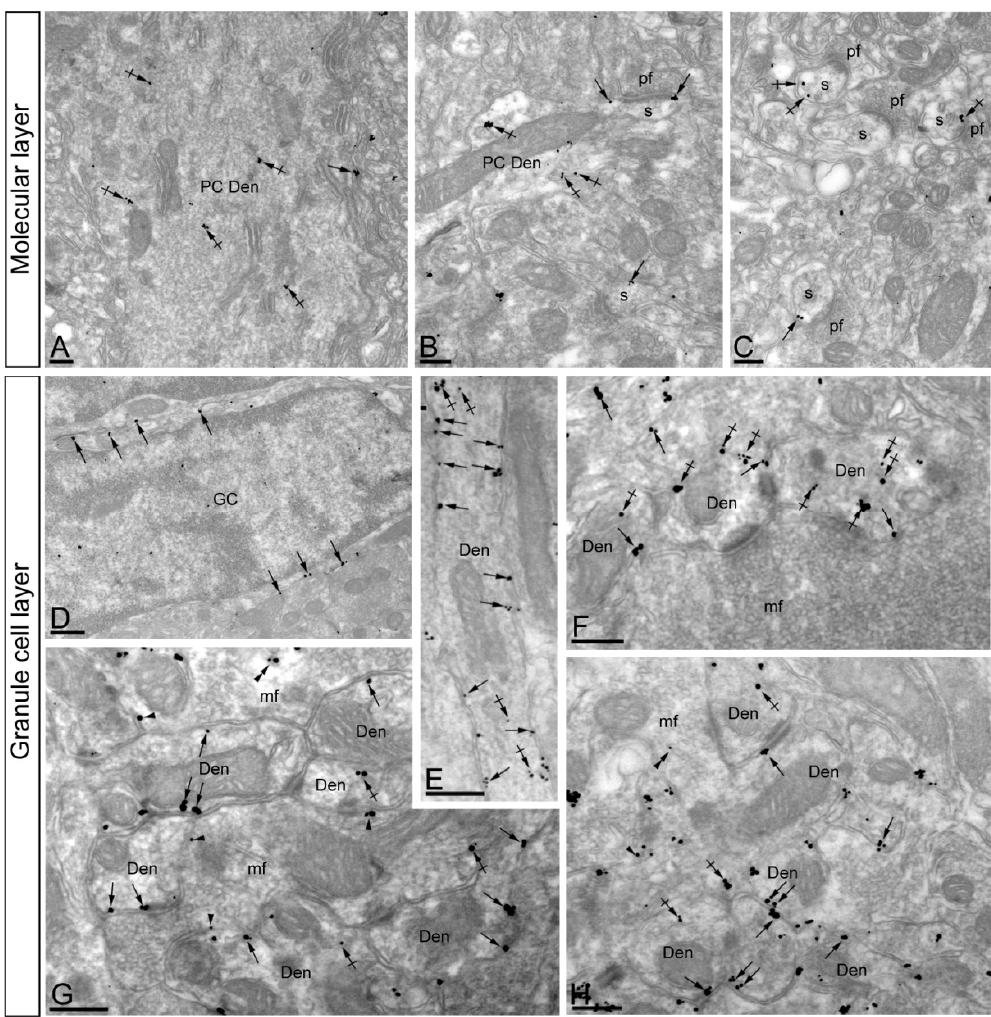
Figure 5. Subcellular localisation of Kv channel interacting protein (KChIP) subunit KChIP4 in the cerebellum. Electron micrographs showing immunoparticles for KChIP4 in the cerebellar cortex, as detected using the pre-embedding immunogold technique. ( A – C ) In the molecular layer, KChIP4 immunoparticles were detected in Purkinje cells, distributed along the extrasynaptic plasma membrane (arrows) of dendritic shafts (Den) and dendritic spines (s), as well as at intracellular sites (crossed arrows). ( D – H ) In the granule cell layer, immunoparticles for KChIP4 were mostly distributed along the somatic plasma membrane (arrows) and dendrites (Den) of granule cells (GC), as well as at intracellular sites (crossed arrows). At presynaptic sites, immunoparticles for KChIP4 were found along the plasma membrane (arrowheads) and intracellular sites (double arrowheads) of mossy fibre axon terminals (mf). Scale bars: ( A – C , E – H ), 250 nm; ( D ), 500 nm. To determine the location of KChIP4 immunoparticles relative to glutamate release sites, we analysed the position of immunoparticles in relation to the closest edge of the postsynaptic densities (PSDs) of PC spines (Figure 6D). This analysis showed that approximately 74.2% of immunoparticles ( n = 66 immunoparticles on 42 spines) were located within a distance of 300 nm from the edge of the PSDs (Figure